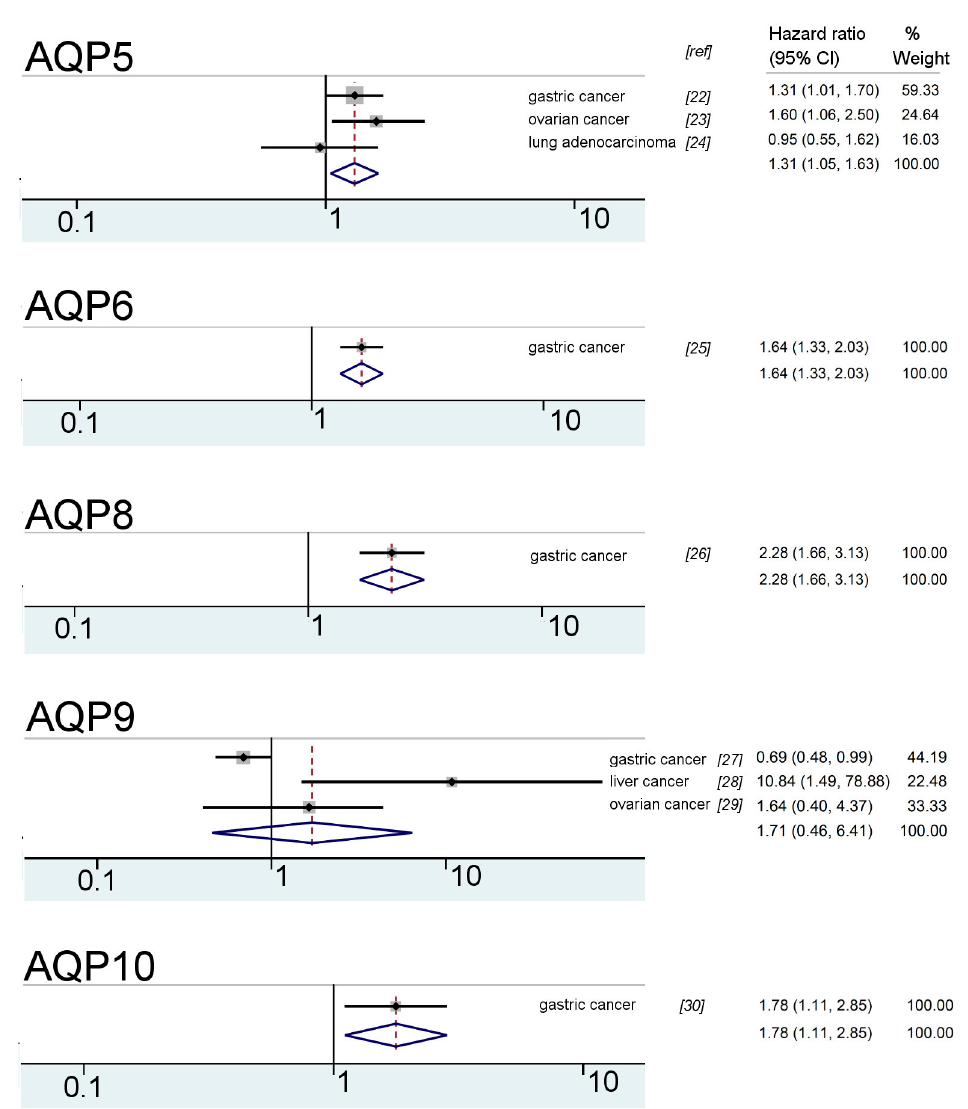
Figure 2. Forest plots compiled for aquaporin (AQP) classes, with hazard ratio and confidence interval (CI) (CI) data extracted from the published literature, based on analyses of levels of protein, RNA or